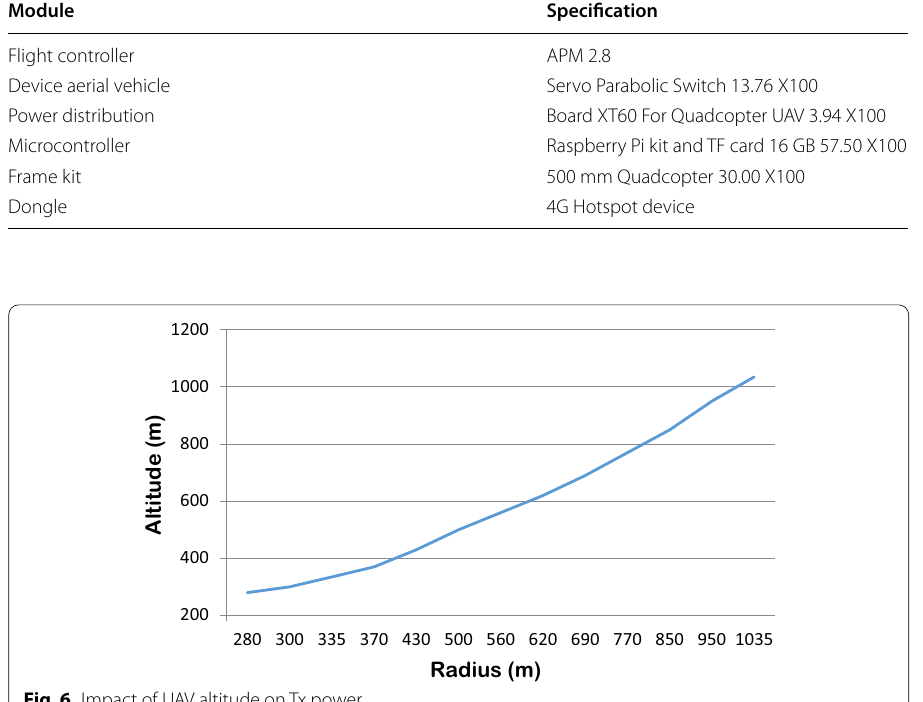
Fig. 6 Impact of UAV altitude on Tx